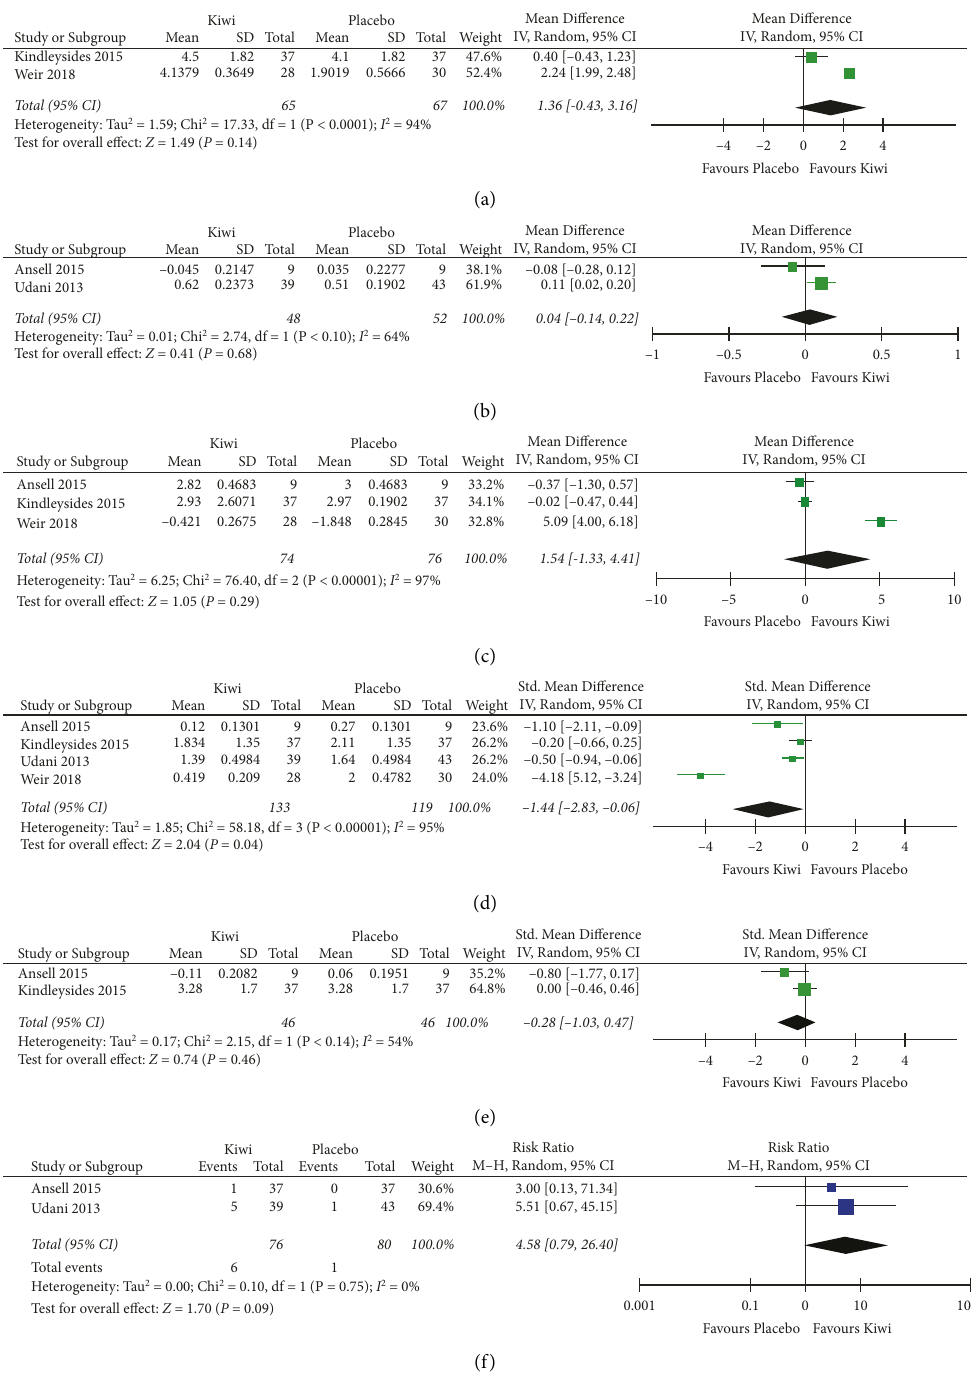
Figure 3: Forest plots for kiwifruits product vs. placebo. (a) Weekly frequency of spontaneous bowel movements. (b) Daily frequency of spontaneous bowel movements. (c) Bristol stool chart score (higher number indicates softer stool; Weir 2018 is negative as they reversed the scale). (d) Abdominal pain (lower score indicates improved abdominal pain). (e) Straining (lower score indicates less straining). (f) Adverse events (only available for kiwifruits vs. placebo and include